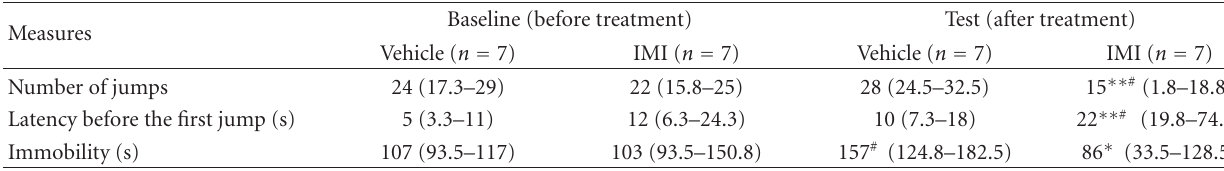
Table 2: E ff ects of subchronic imipramine (IMI) treatment (10mg/kg/14 d, IP, n = 7, median with limits of interquartile range